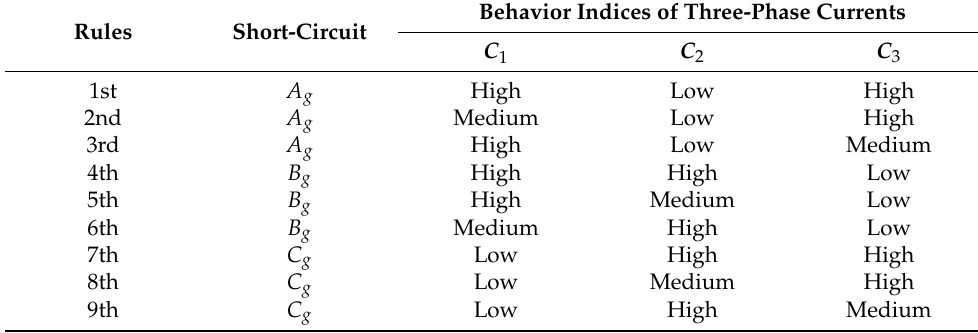
Table 2. FIS rules set to classify single-phase short-circuit.